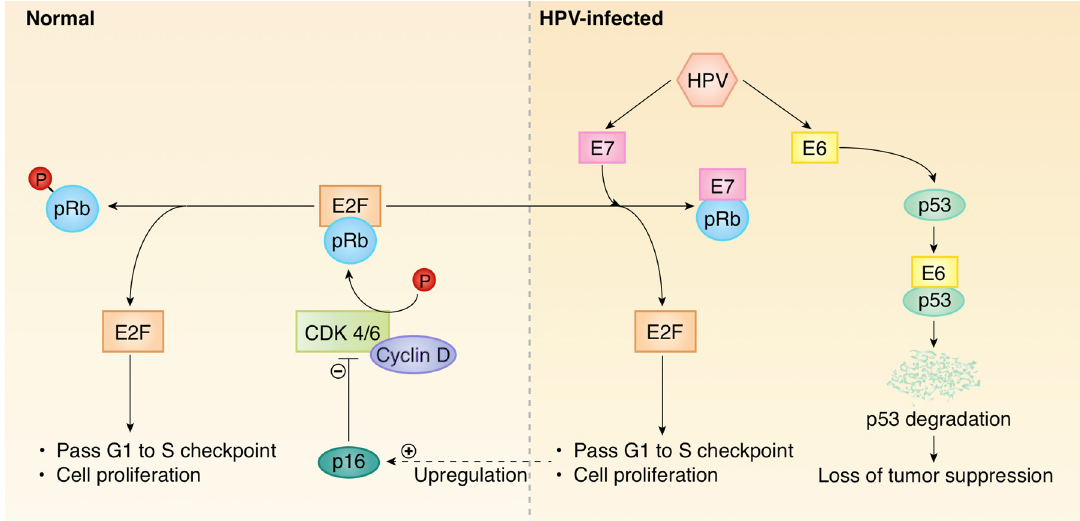
Figure 1. Human papillomavirus (HPV) + cancer increases expression of p16. Left panel: Normal, uninfected cell. Cyclin D–cyclin dependent kinase (CDK) 4 / 6 complex initiates phosphorylation of the tumor suppressor protein, pRb. The hyperphosphorylation of pRb leads to release of the transcription factor E2F into its active state, which drives the expression of downstream gene products allowing the cell to transition from the G1 to S phase. As a cyclin kinase inhibitor, p16 is a tumor suppressor and negative regulator of the cyclin D–CDK 4 / 6 complex. Right panel: HPV infected cell. When the transcription factor E2F is bound to pRb, it remains inactive. The overexpression of the E7 oncoprotein by high-risk HPV subtypes disrupts the E2F–pRb complex by displacing E2F and binding to pRb. The subsequent release of E2F into its active state drives the expression of downstream gene products, allowing the cell to transition from the G1 to S phase. In a regulatory feedback attempt to inhibit further cell proliferation, p16 is upregulated, and thus can be a surrogate for HPV + tumors. The overexpression E6 oncoprotein acts via a separate mechanism. E6 binds to the tumor suppressor protein, p53, and ultimately leads to degradation of p53. Loss of the regulatory function of p53 causes aberrant propagation of the cell cycle and prevents apoptosis.